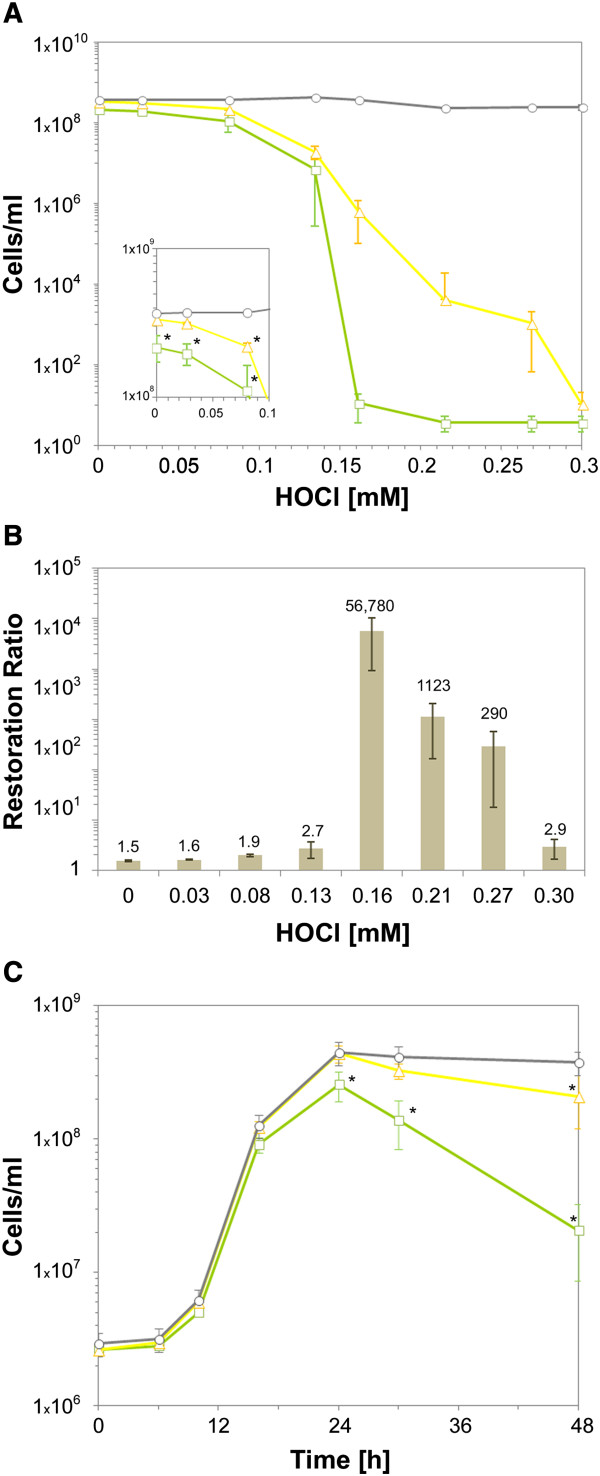
Restoration of the culturability of L. pneumophila Philadelphia cells on supplemented medium (BCYES). (A) Number of culturable cells observed on standard medium (□), total cells (○) and culturable cells observed on the supplemented medium (∆) as a function of HOCl concentration (mM). The results reported are means of three independent experiments. Inset shows a magnification of the region of the plots corresponding to HOCl concentrations lower than 0.1 mM. Stars indicate that the number of culturable cells was significantly lower (p < 0.05) than the total number of cells. (B) Restoration ratio (Number of culturable L. pneumophila cells on supplemented medium divided by that on standard medium) as a function of HOCl concentration. The restoration ratio is given above each bar. (C) Number of culturable cells as assessed on the standard medium (□), total cells (○) and culturable cells as assessed on the supplemented medium (∆) as a function of time (h) for cultures in the liquid standard medium (YEC) at 37°C. The results reported are means of three independent experiments (Errors bars = SD). Stars indicate that the number of culturable cells is significantly lower (p < 0.05) than the total number of cells.